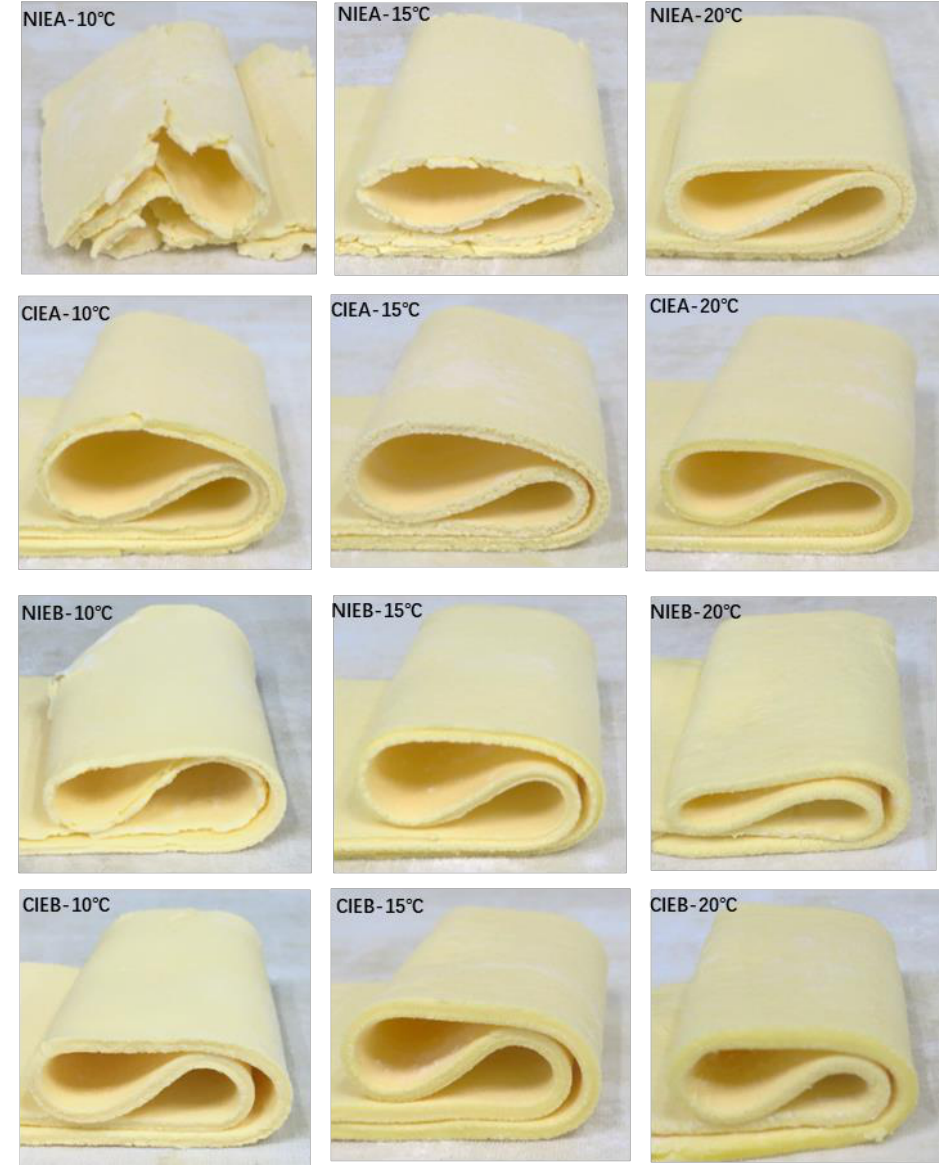
Figure 8. Malleability of different samples at 10 °C, 15 °C, and 20 °C.